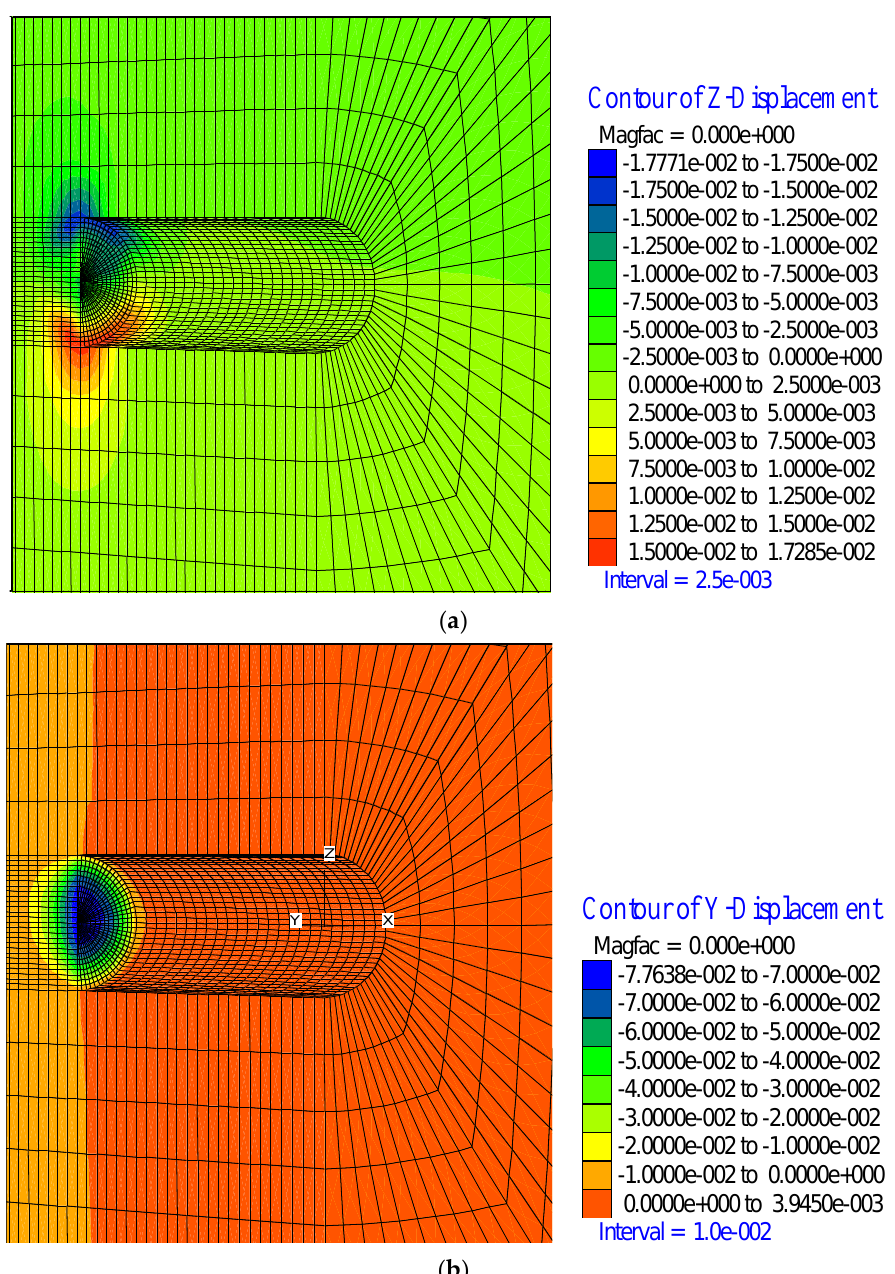
Figure 22. Vertical deformations ( a ) and horizontal deformations ( b ) obtained from the 3D numerical analyses (units in m).